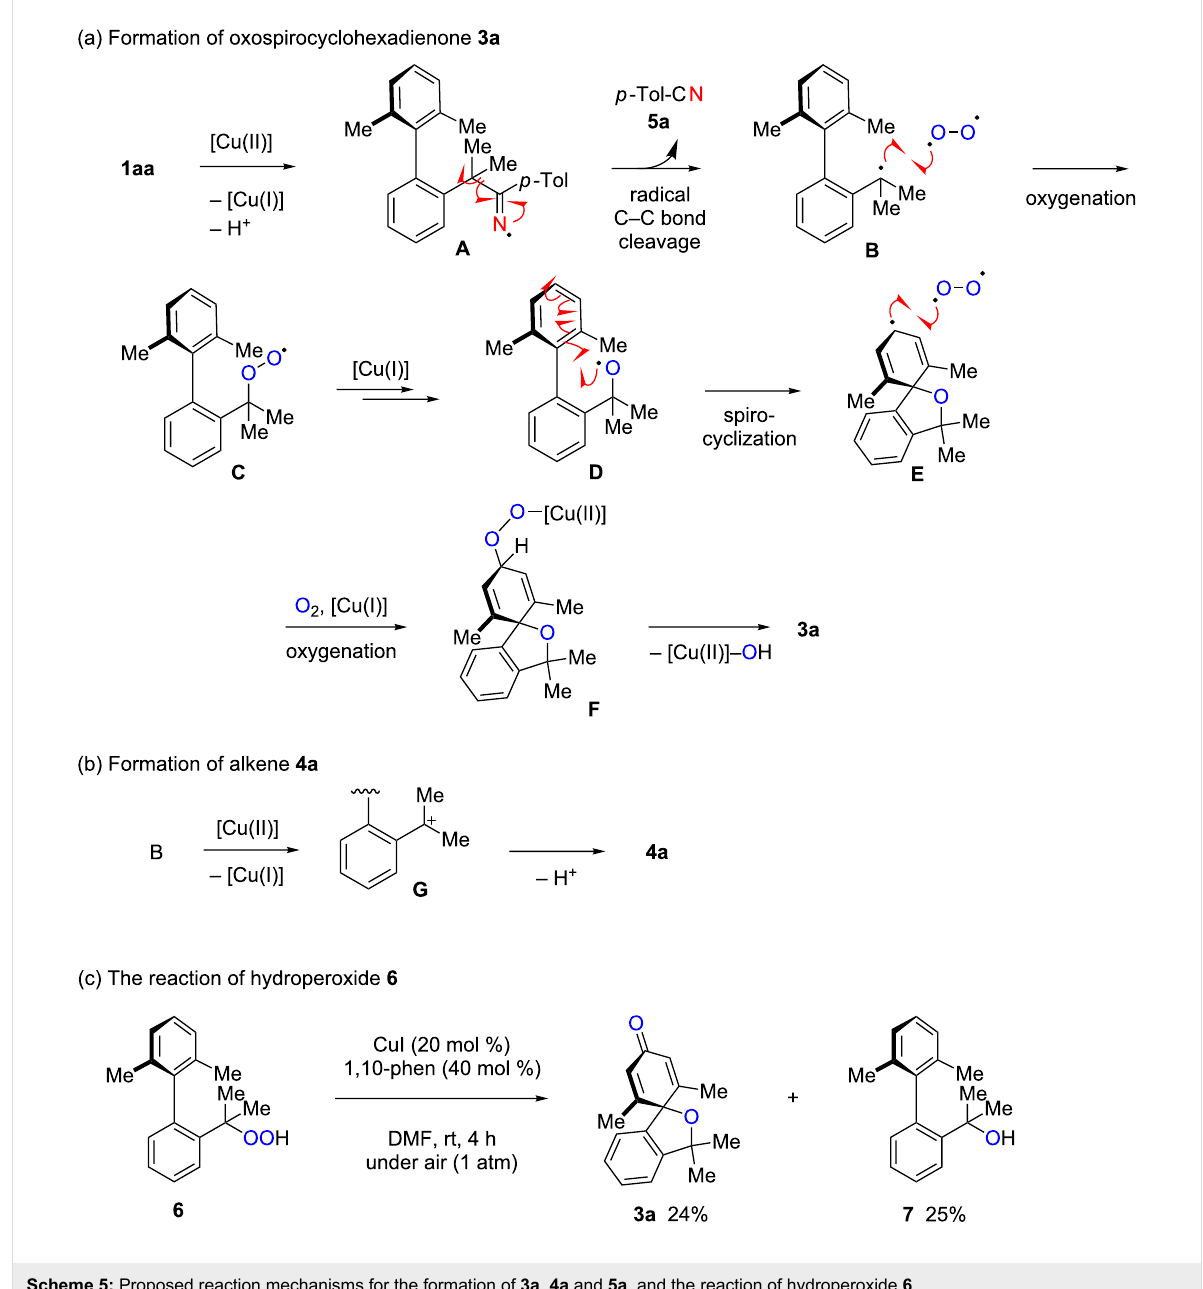
Scheme 5: Proposed reaction mechanisms for the formation of 3a , 4a and 5a , and the reaction of hydroperoxide 6 .